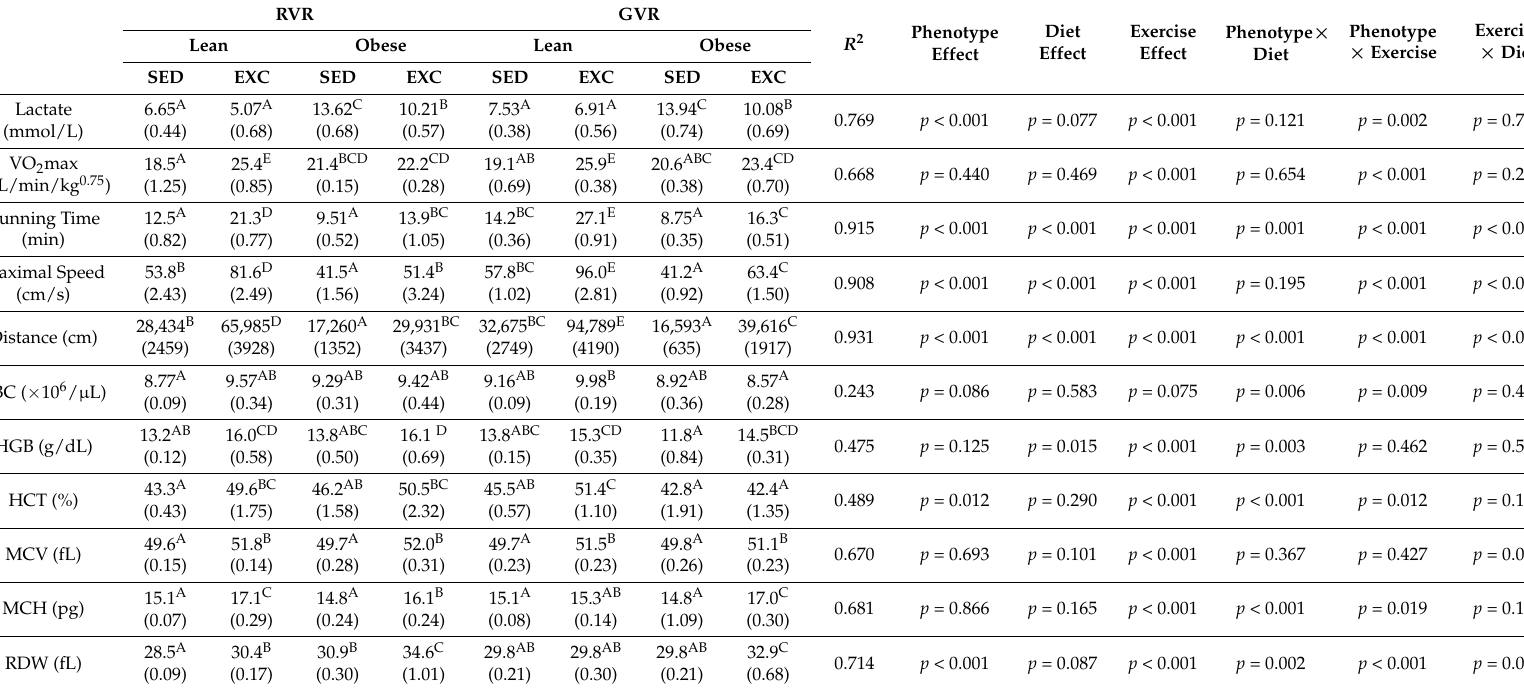
Table 3. Effect of diet, phenotype, and aerobic interval training protocol on aerobic capacity, physical performance and related hematic parameters of Zucker